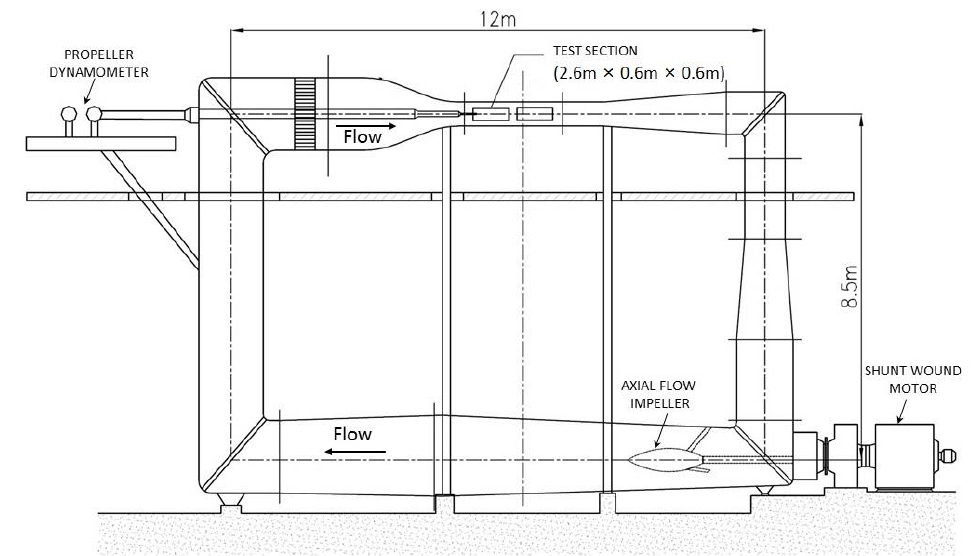
Figure 3. General arrangement of the cavitation tunnel.